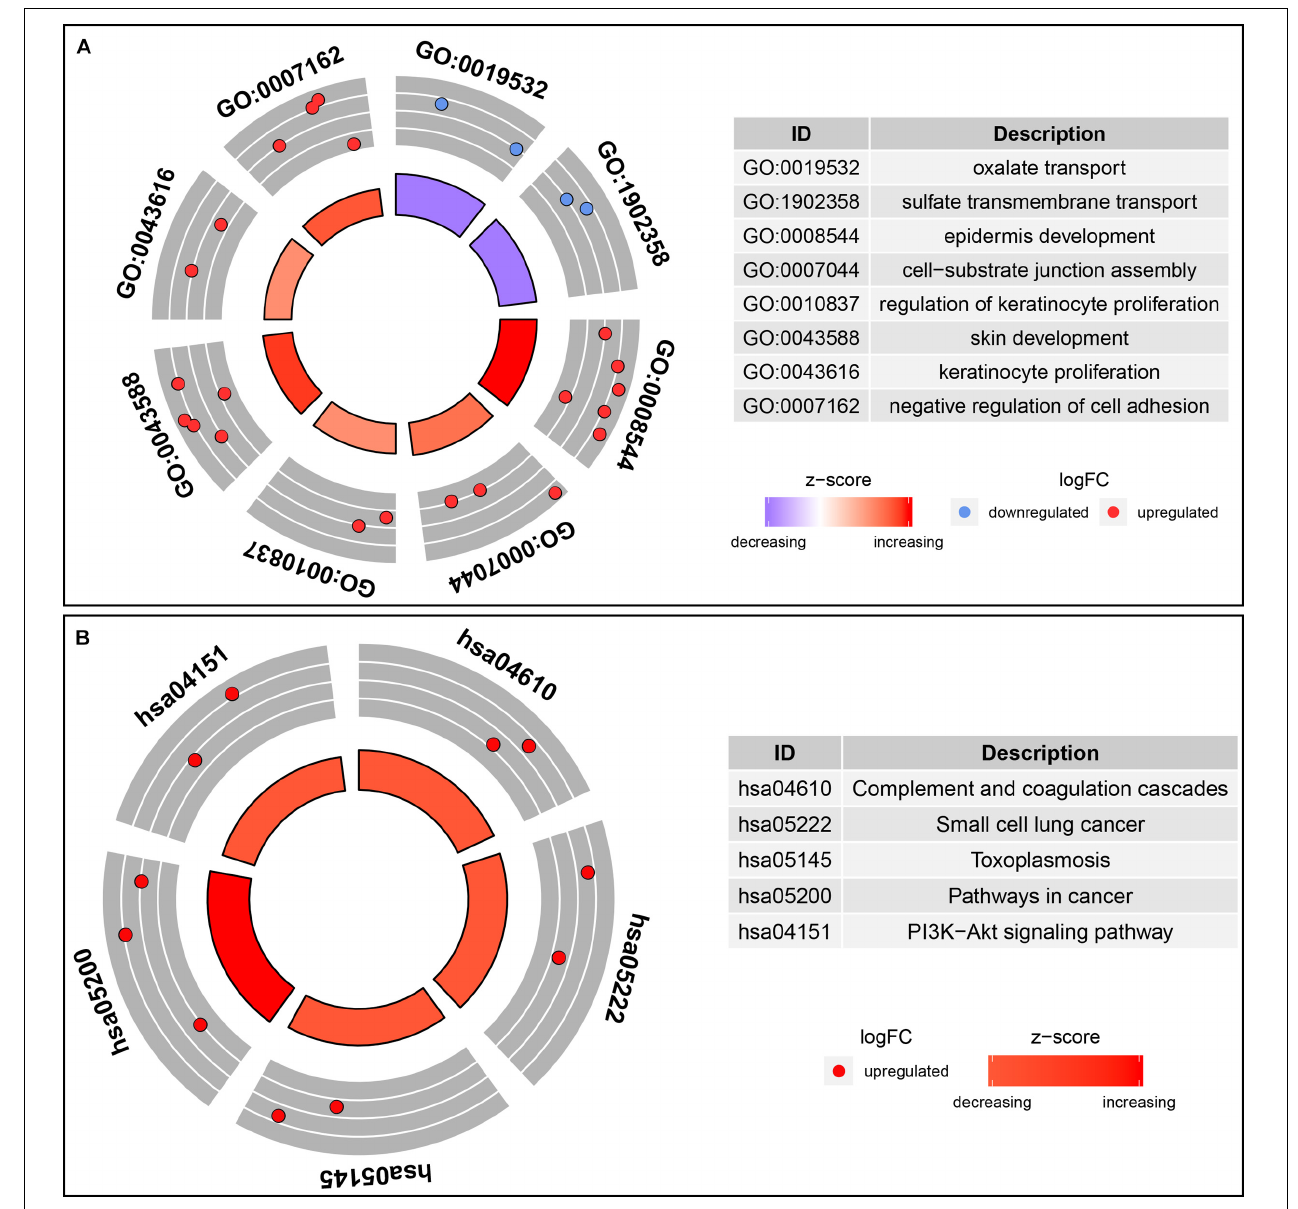
FIGURE 3 | Functional enrichment analysis of methylation-driven genes in thyroid cancer. (A) GO enrichment analysis. (B) KEGG enrichment analysis. The color of inner circle represents z score while the band thickness of inner circle represents the significance of GO terms (log10-adjusted p values). The outer circle represents the expression (log 2 FC) of methylation-driven mRNAs in each enriched GO (gene ontology) term: red dots indicate upregulated methylation-driven mRNAs while blue dots indicate downregulated methylation-driven mRNAs.